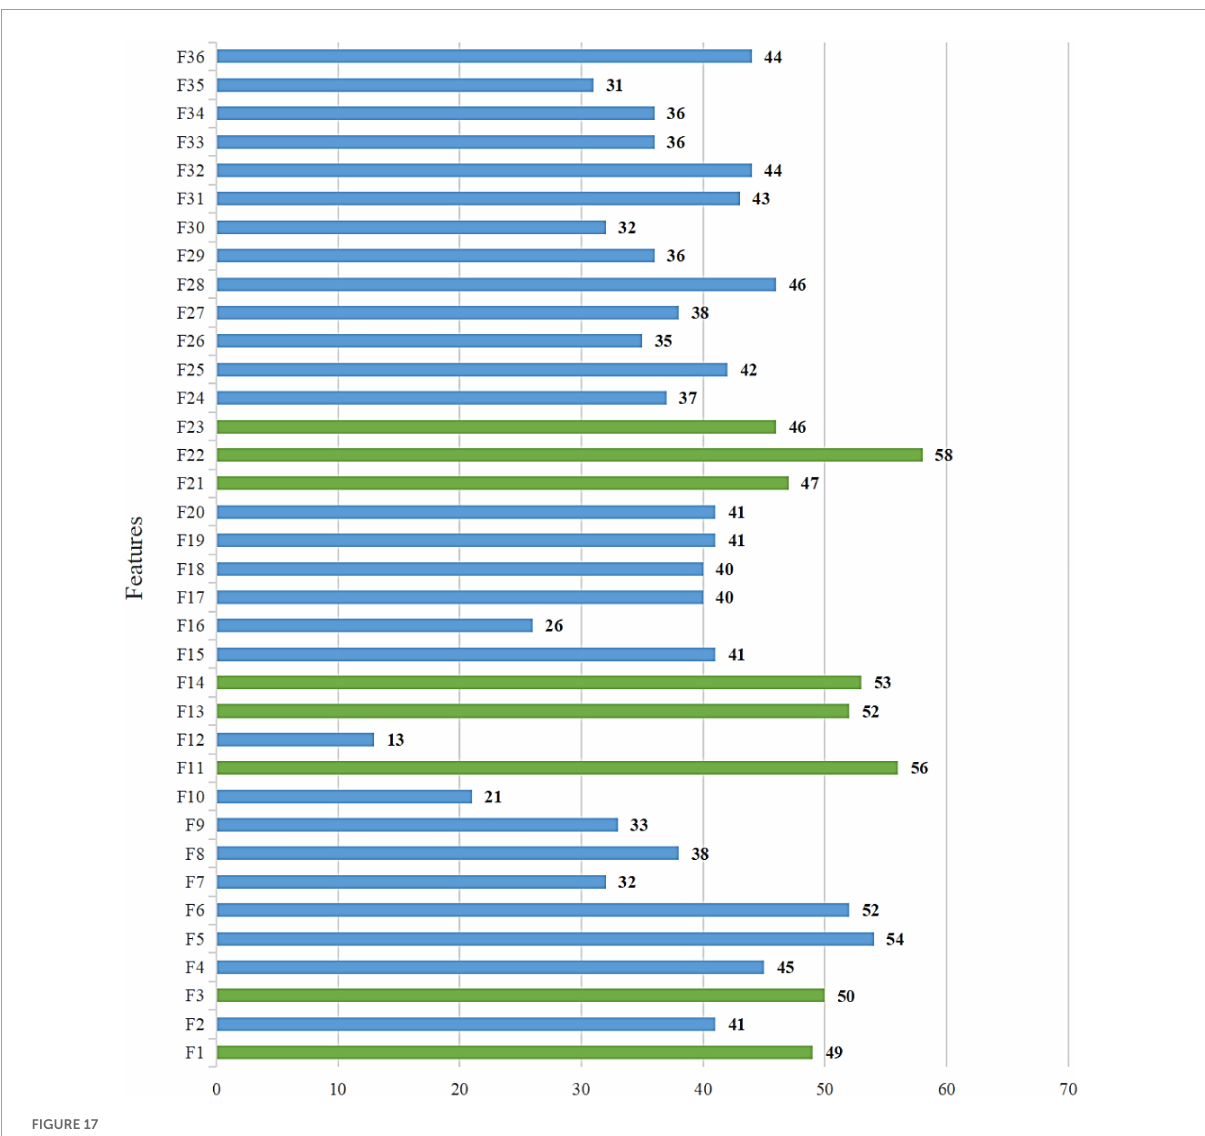
FIGURE17 Results of 10 times 10-fold cross-validation analysis.